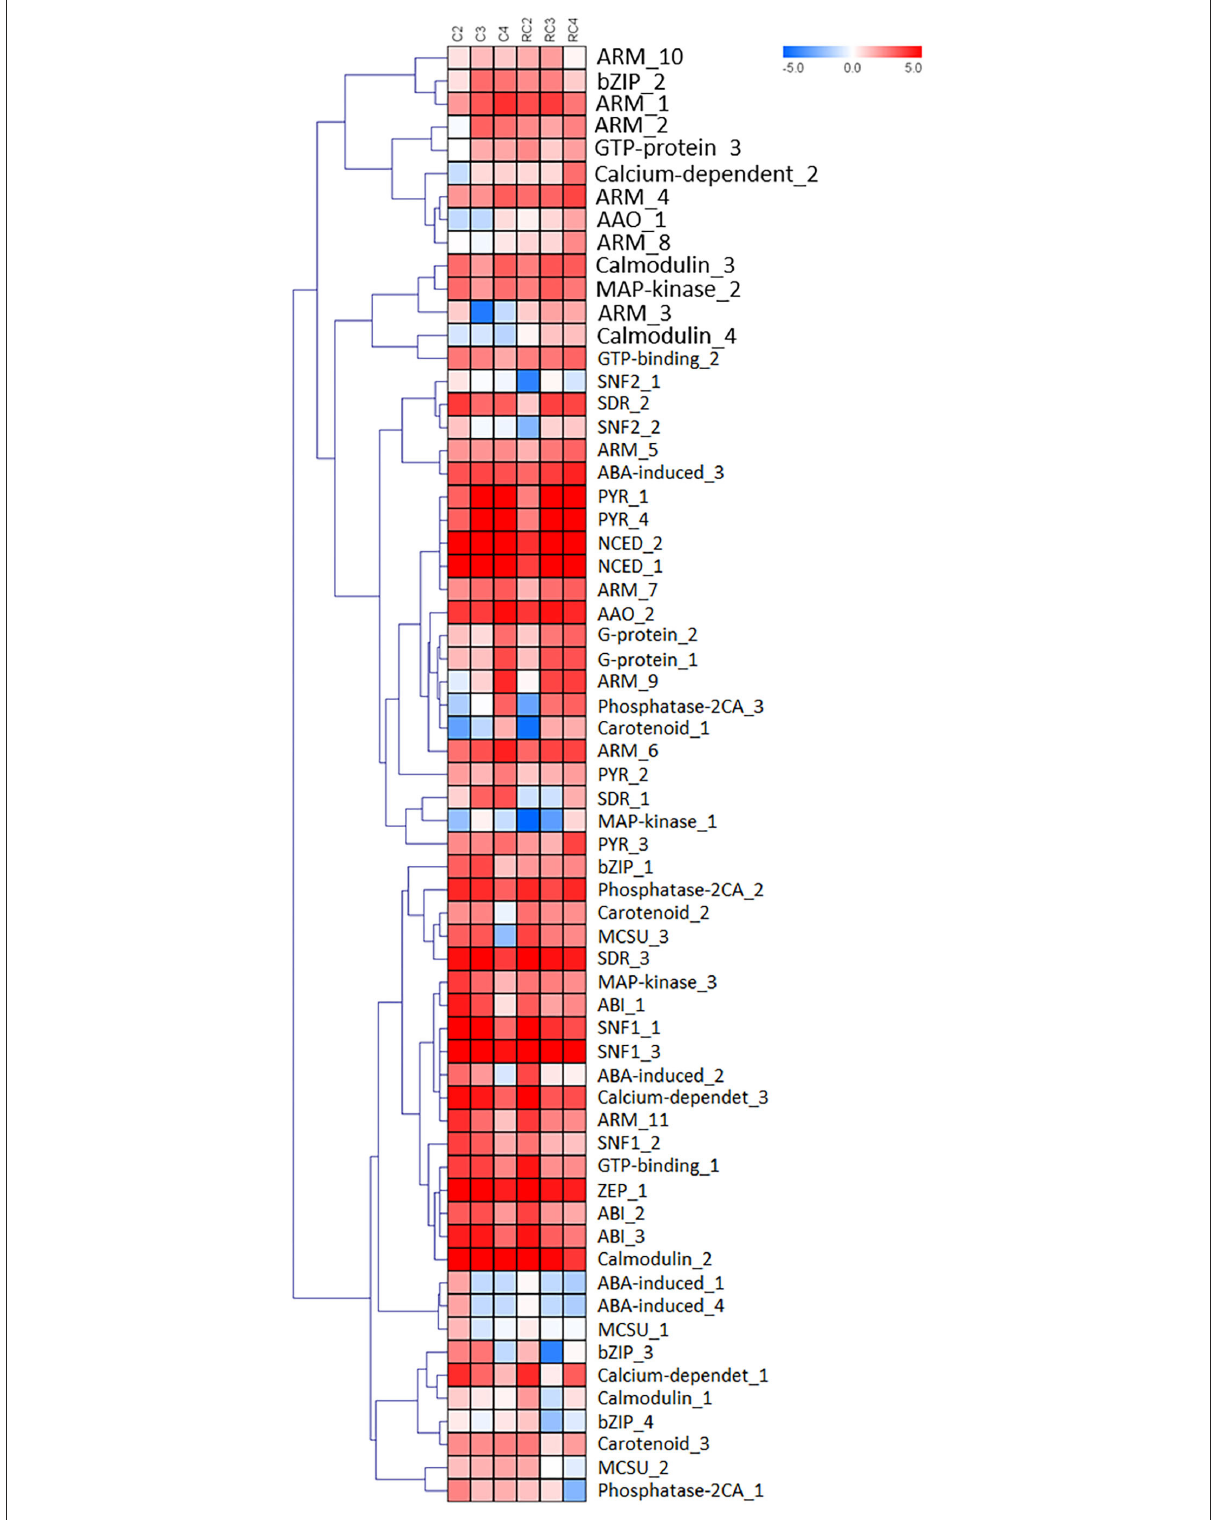
FIGURE6 HeatMap for genes involved in the synthesis of Abscisic acid and receptors. Log2 is calculated to the FPKM value for each gene to delimit extreme values and used to scale expression. To perform hierarchical clustering for fruit developmental stage and tissue type (receptacle and receptacle without achene), we selected the Pearson Correlation distance metric and Average linkage clustering. Levels of decreased expression are shown in blue and increased expression is shown in